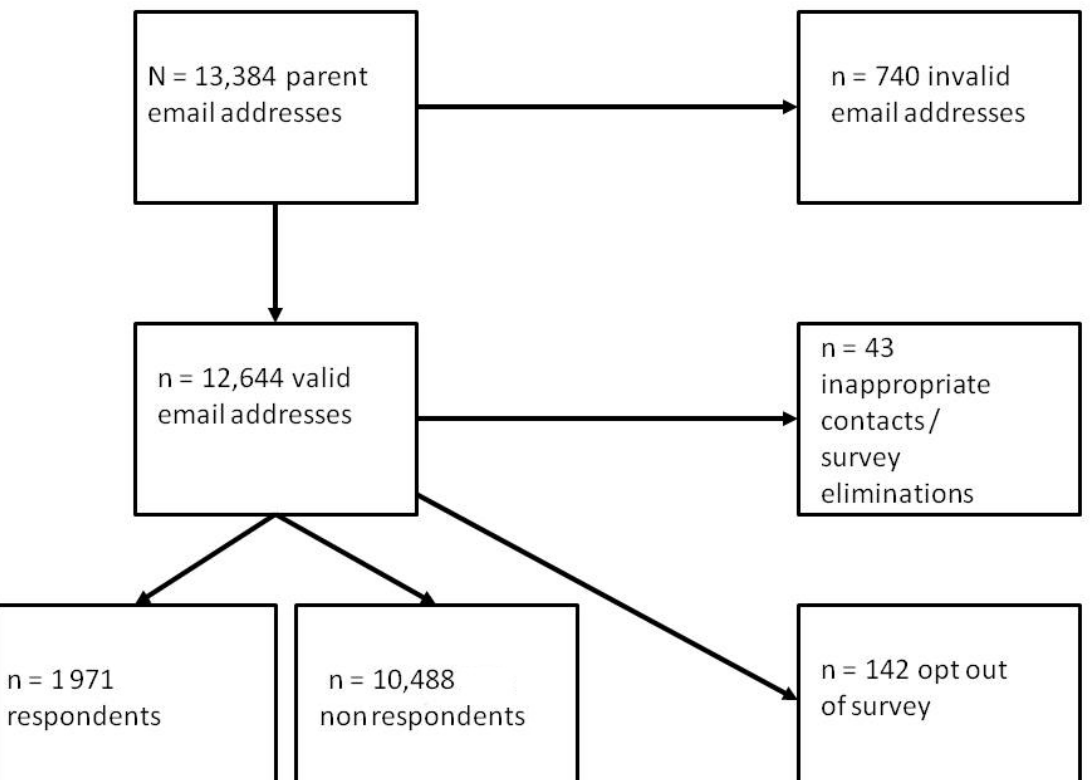
Figure 1. Progress of participants through the